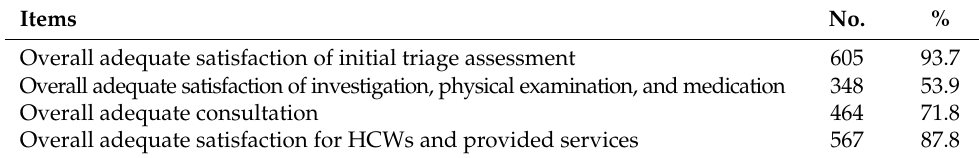
Table 1. Overall adequate satisfaction of